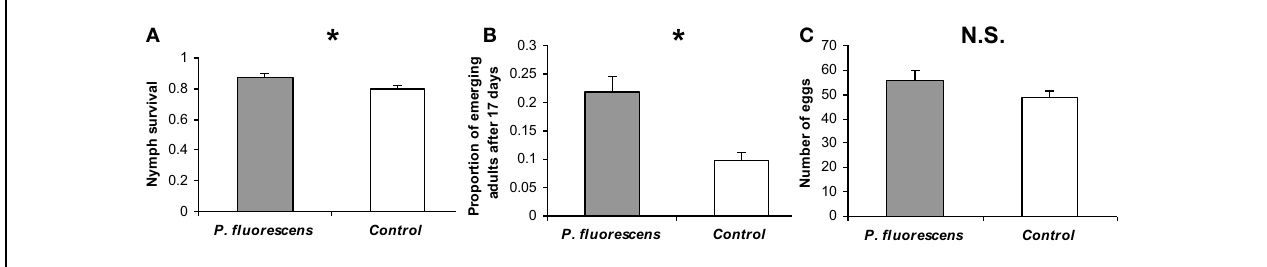
adults by day 17. (C) The mean number of eggs oviposited by 12 females during 24h. Asterisks indicate significant differences ( P ≤ 0 . 05). Errors bars represent standard error of the means ( n = ∼ 30). N.S. = Not